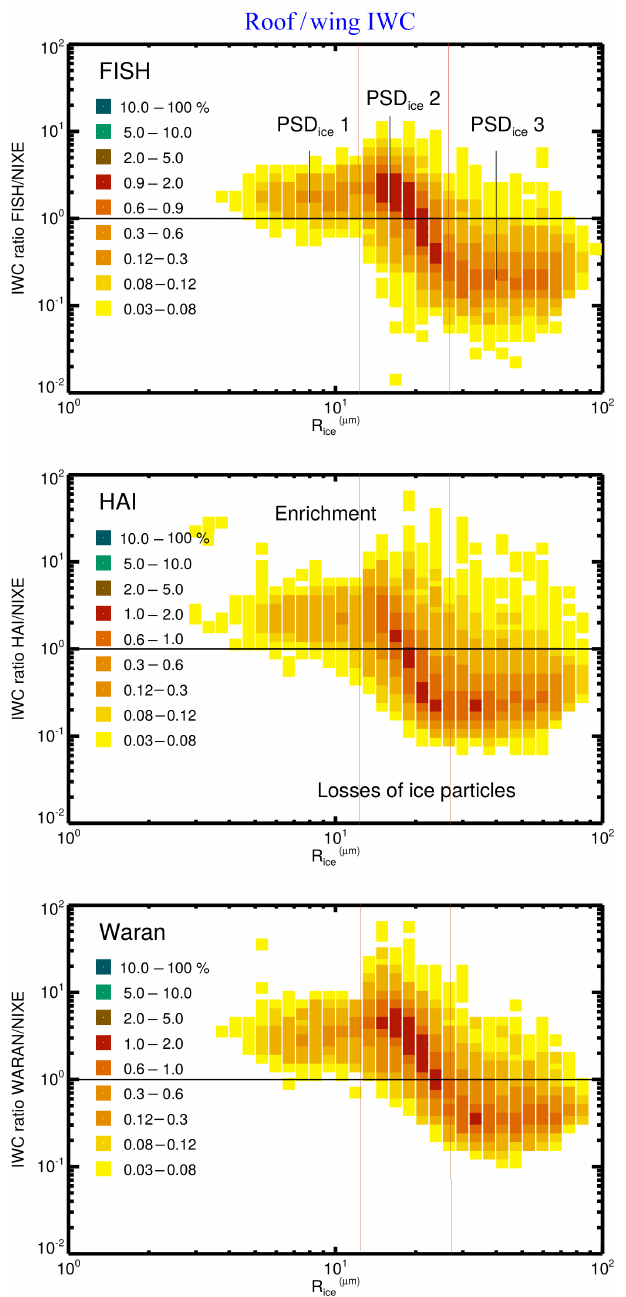
Figure 12. Ratios of roof / wing IWC (roof IWC from FISH, HAI, Waran; wing IWC from NIXE) vs. mean mass R ice .